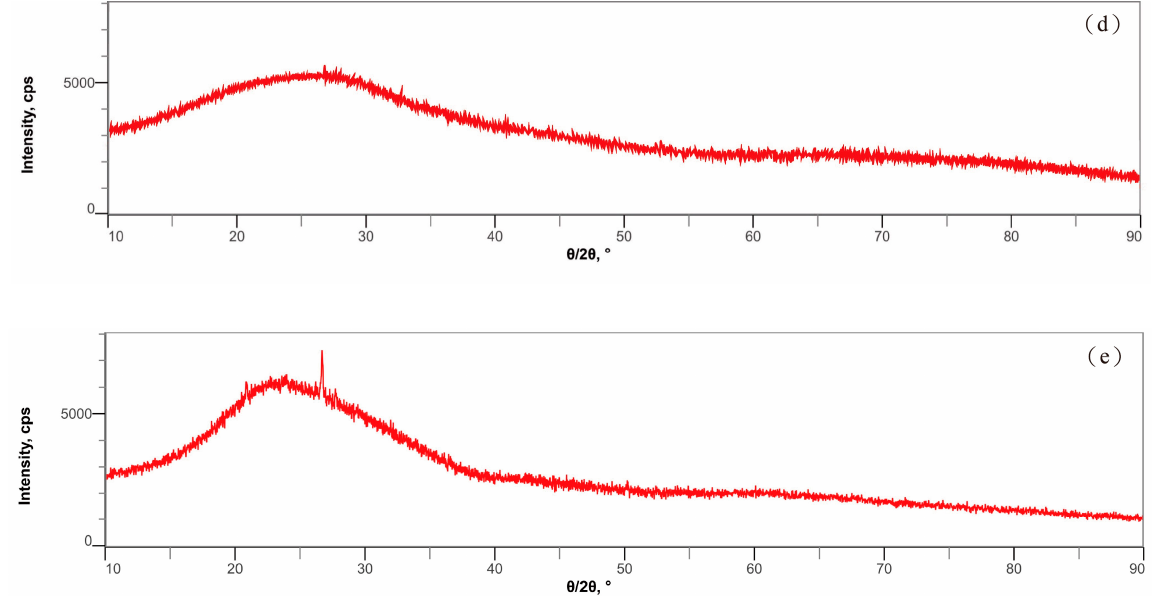
Figure 1. The characteristics of glass fiber waste removed by organic solvents: ( a ) Original glass fiber waste; ( b ) treated by ethyl acetate under ultrasonic for 5 h; ( c ) treated by toluene under ultrasonic for 5 h; ( d ) XRD spectrum of glass fiber waste treated by organic solvent; ( e ) XRD spectrum of glass fiber waste.